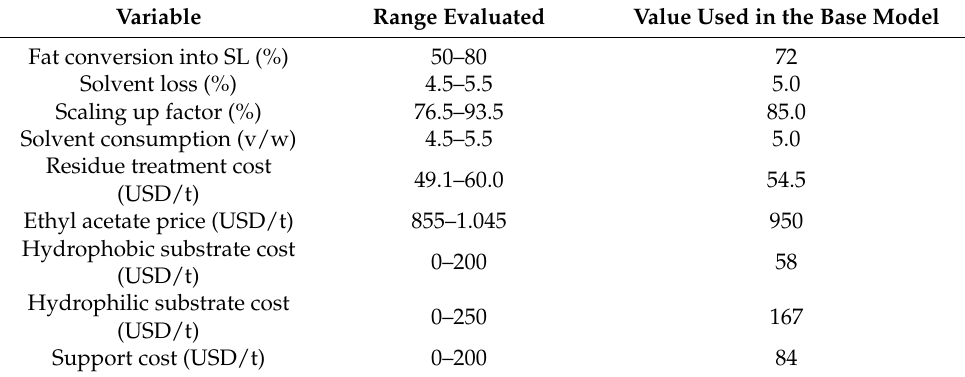
Table 4. Variables used for the sensitivity